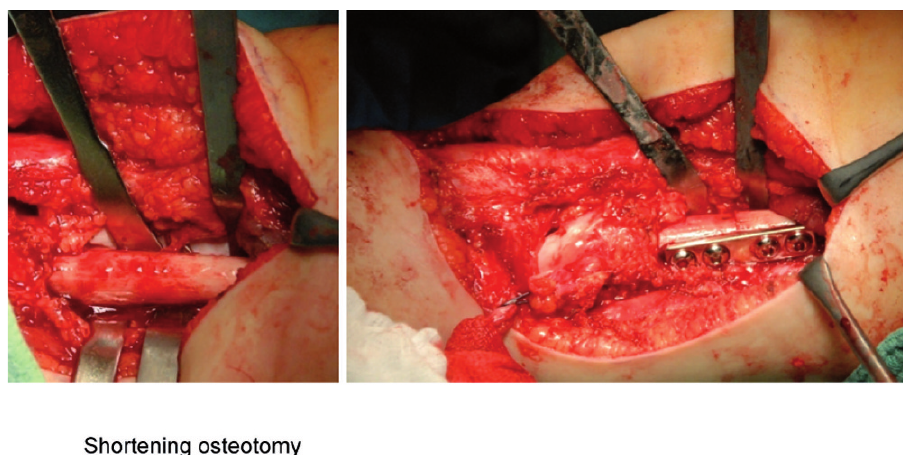
Figure 5 - Shortening osteotomy.